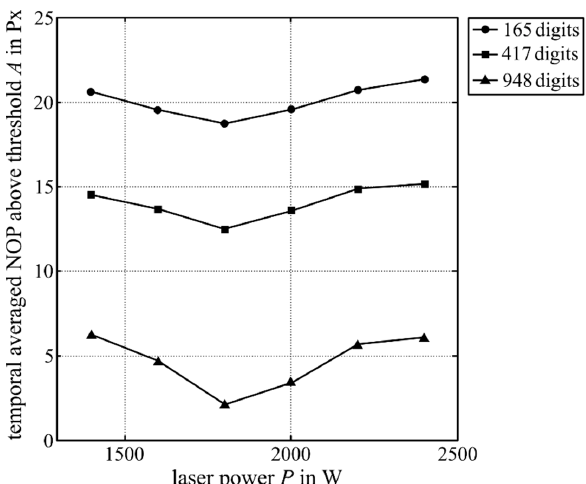
Figure A2. Temporally averaged NOP (over the intensity thresholds 163 digits, 417 digits and 948 digits) over the laser power variation. The three curves follow the same characteristic, which is most pronounced in the curve of 948